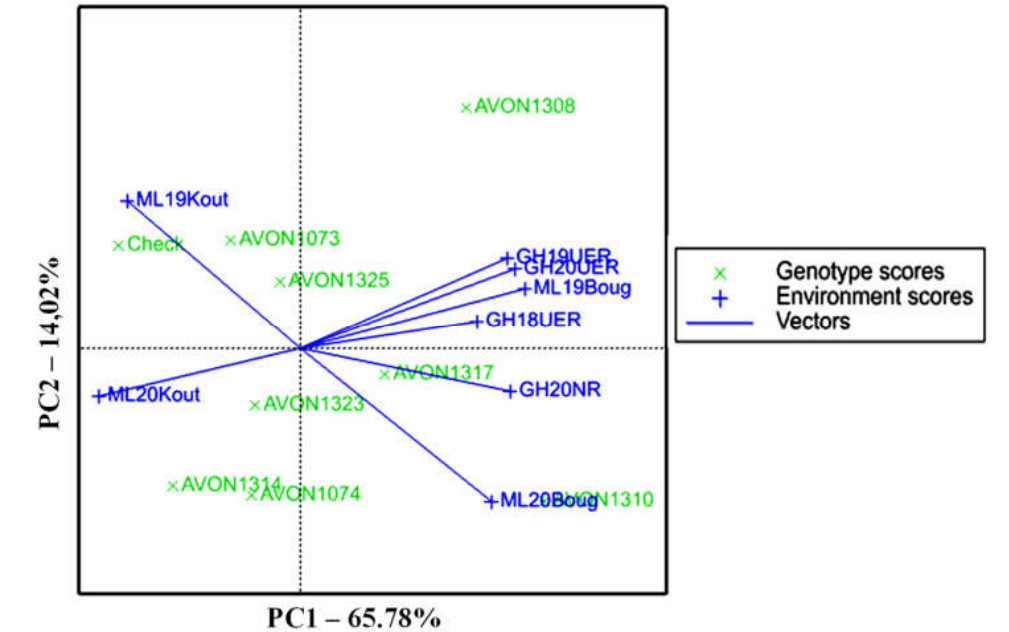
Figure 1. Vector view of the AMMI biplot (PC1 and PC2) of onion yield showing the relationship between tested varieties and environments. GH19UER, Upper East Region, 2019; GH20UER, Upper East Region, 2020; GH20NR, Northern Region; ML19Kout, Koutiala 2019; ML20Kout, Koutiala 2020; ML19Boug, Bougouni 2019; ML20Boug, Bougouni 2020. Dotted vertical and horizontal lines indicate points where the PC1 and PC2 axes had respective values of zero.